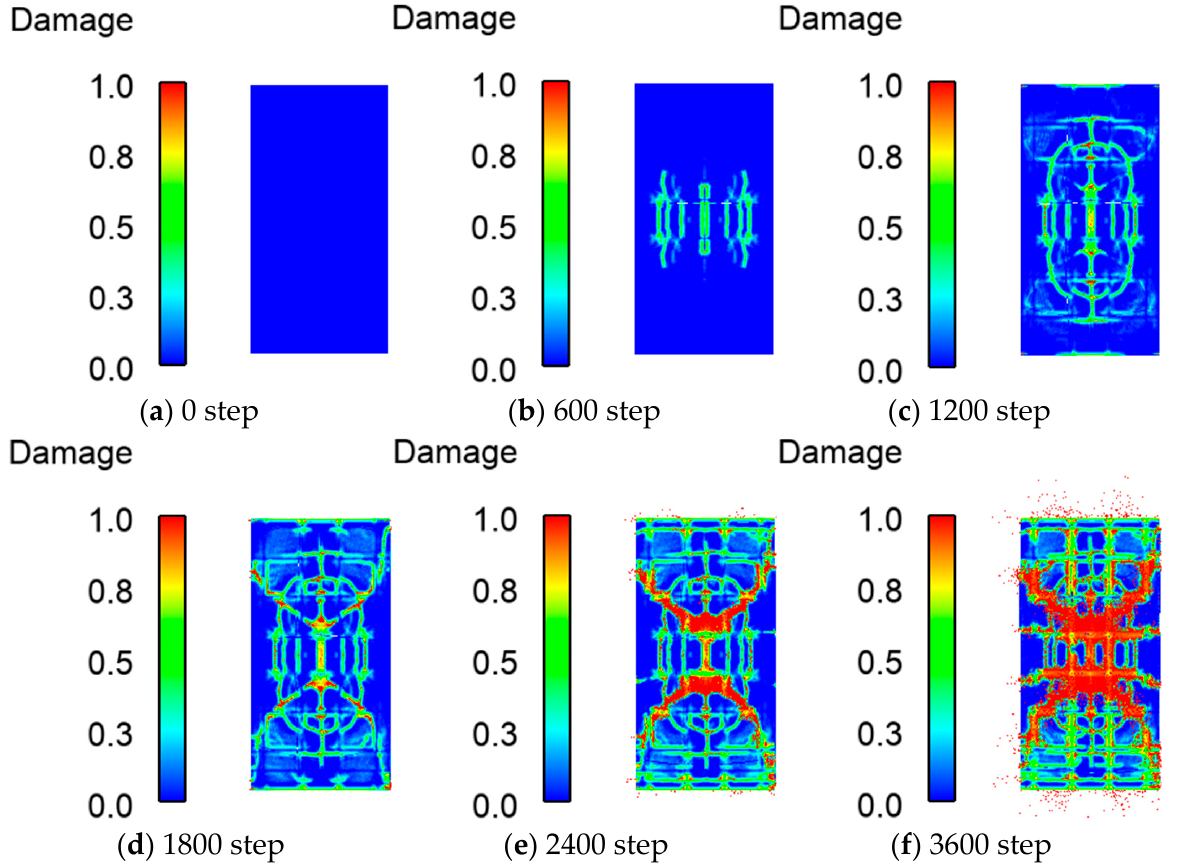
Figure 10. Crack development process at the front of the RC shear wall after falling hammer contact with the RC shear wall.